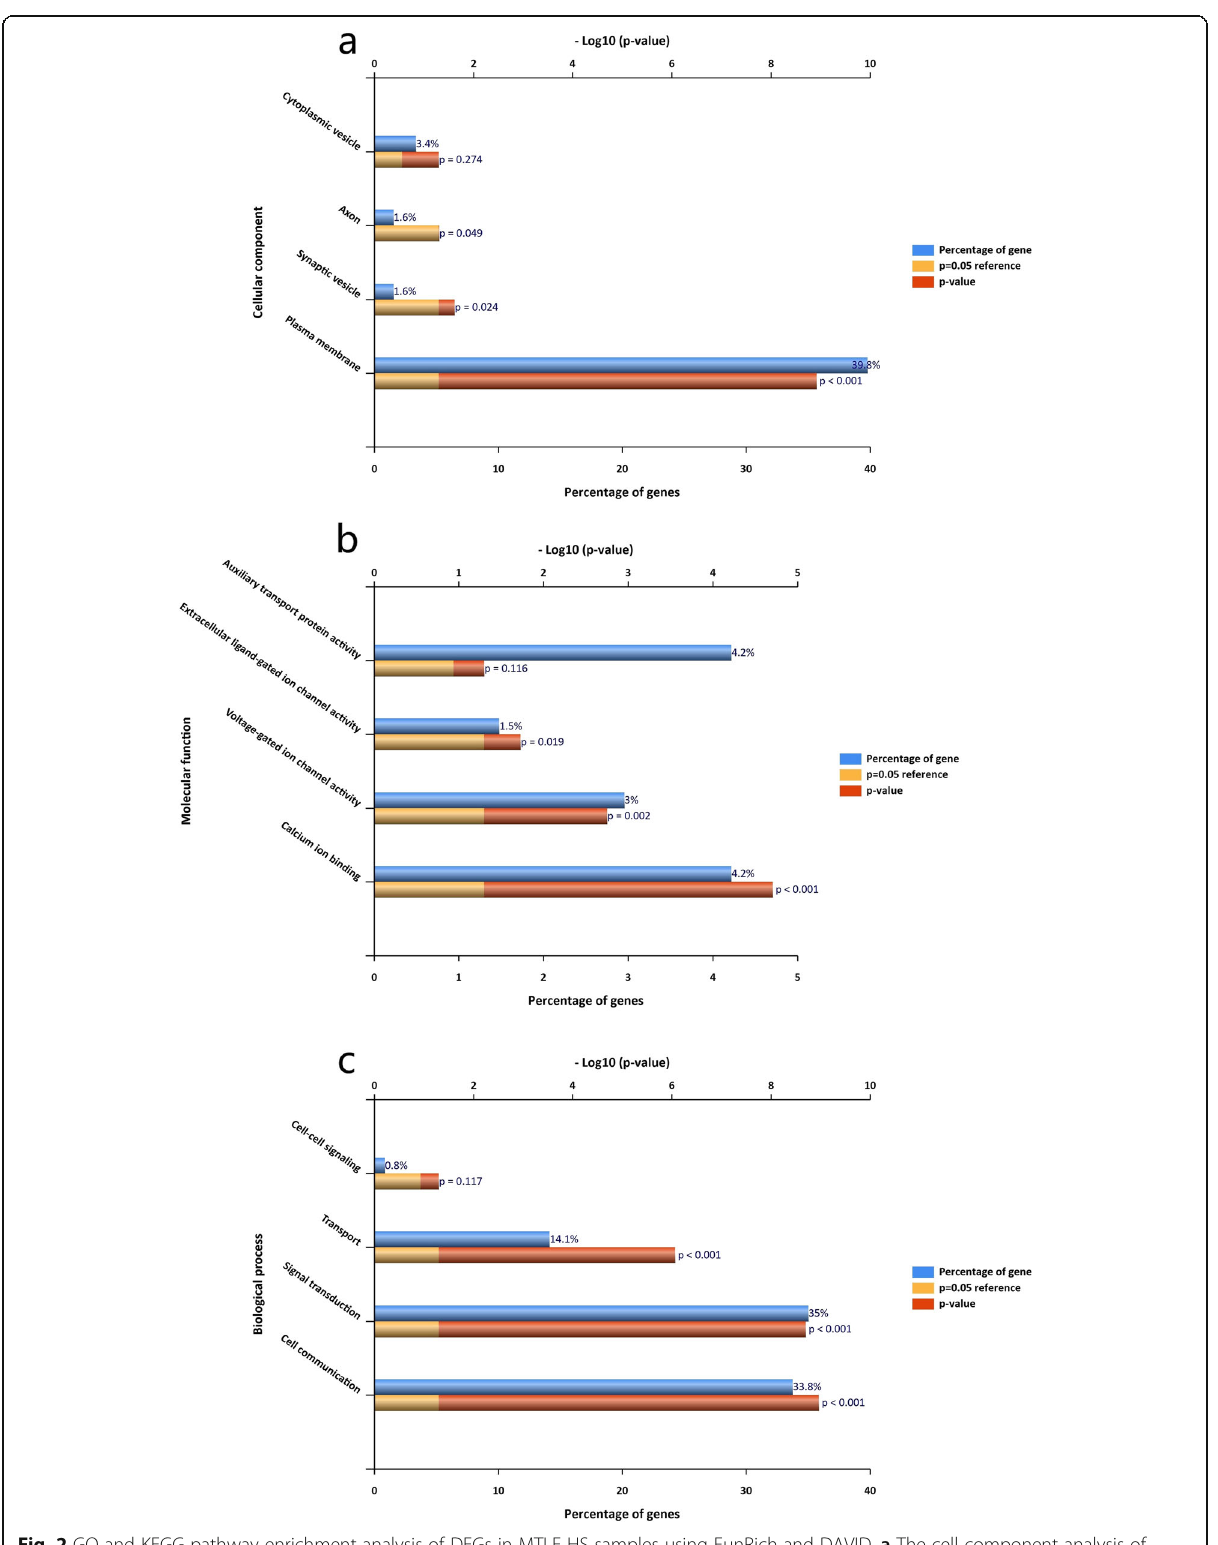
Fig. 2 GO and KEGG pathway enrichment analysis of DEGs in MTLE-HS samples using FunRich and DAVID. a The cell component analysis of DEGs. b The molecular function of DEGs. c The biological process analysis of